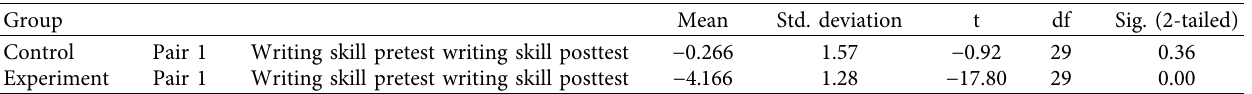
Table 17: Paired differences.